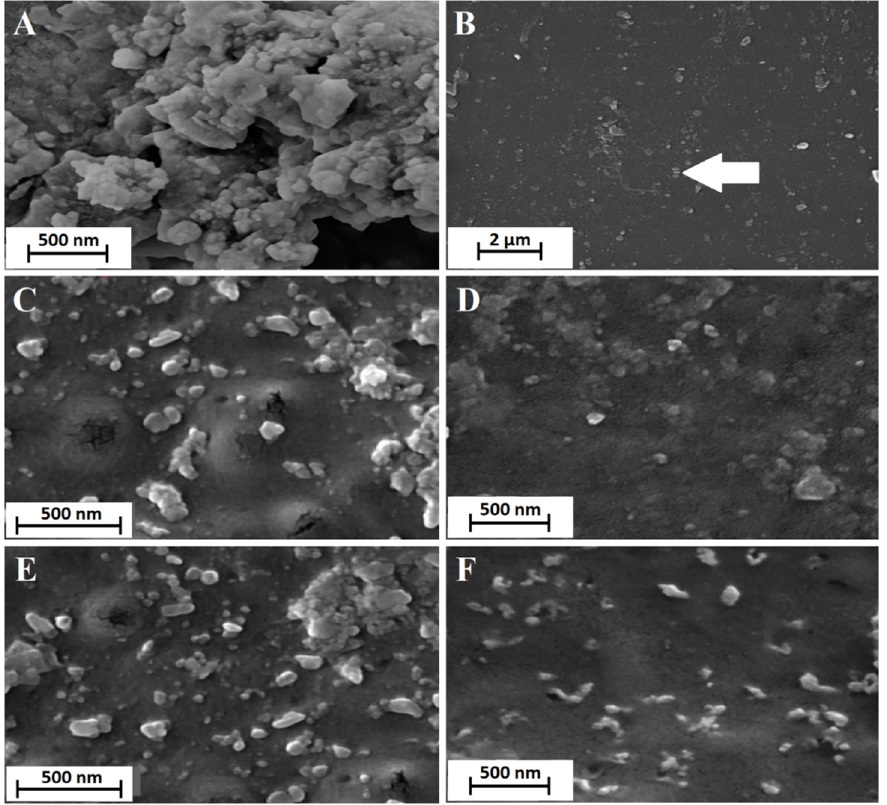
Figure 3. SEM images of erythromycin-loaded nanoparticles ( A , B ), CD-β insert ( C ), GEL insert ( D ), ALG insert ( E ), and CD-α insert ( F ).